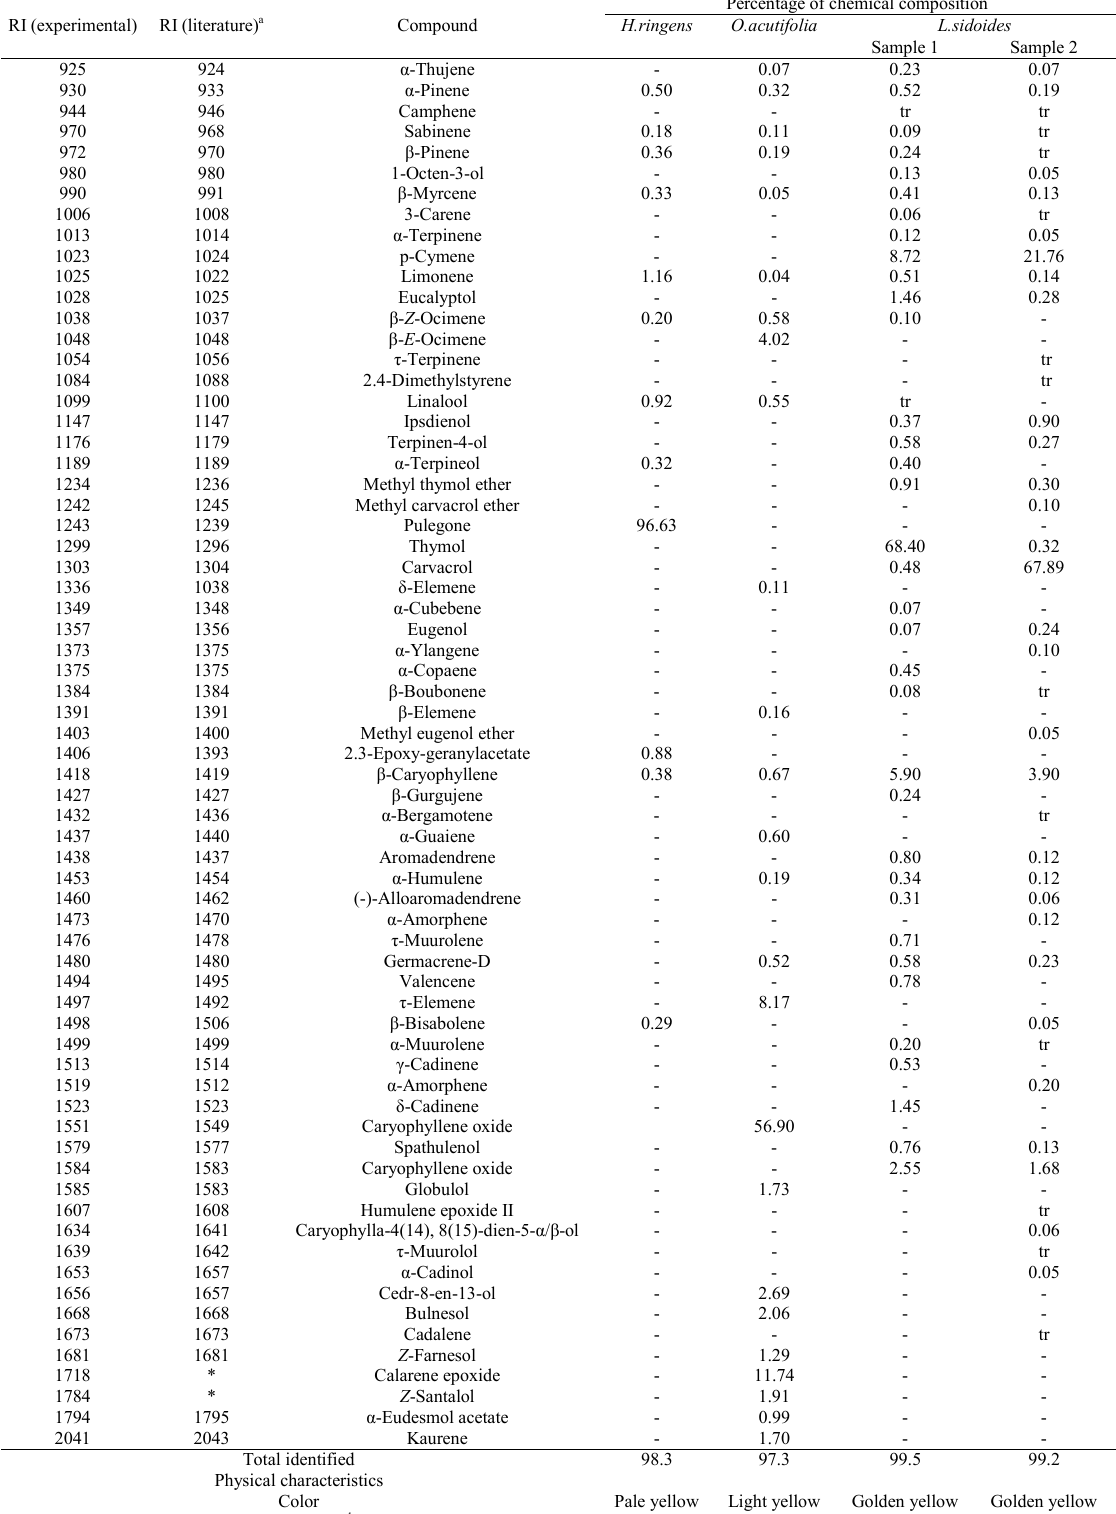
Table 1. Chemical compositions and physical characteristics of the essential oils obtained from Hesperozygis ringens , Ocotea acutifolia and Lippia sidoides. *Retention index did not report; RI: Retention index; tr: Trace (<0.05%); a Adams (2001), NIST (2005). RI (experimental) RI (literature)